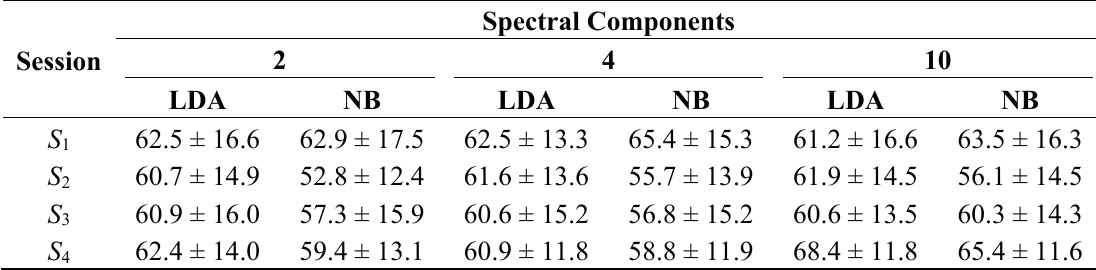
Table 5. Average hit rates using the spectral components of two channels (C3 and C4).